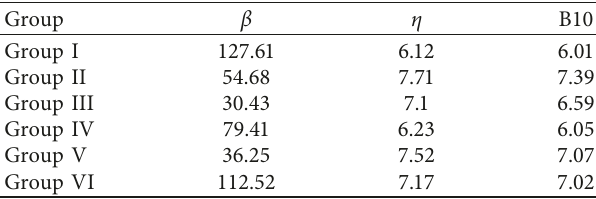
Table 5: Mean push-out bond strength of each group together with the results from the Weibull statistical